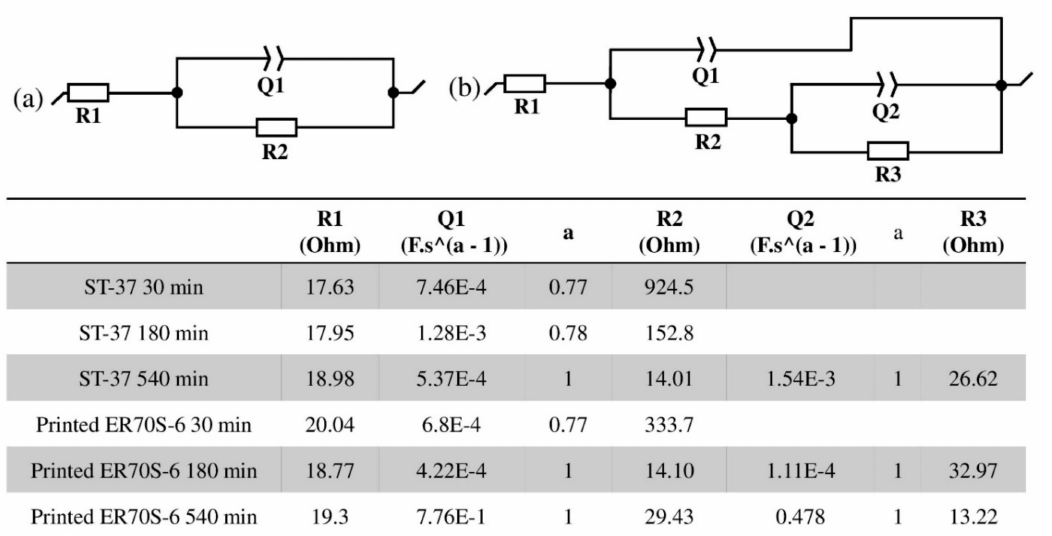
Figure 13. Electrical equivalent circuits and fitted parameters for the Nyquist diagrams shown in Figure 9, after various immersion times. ( a ) initial immersion, ( b ) long-term